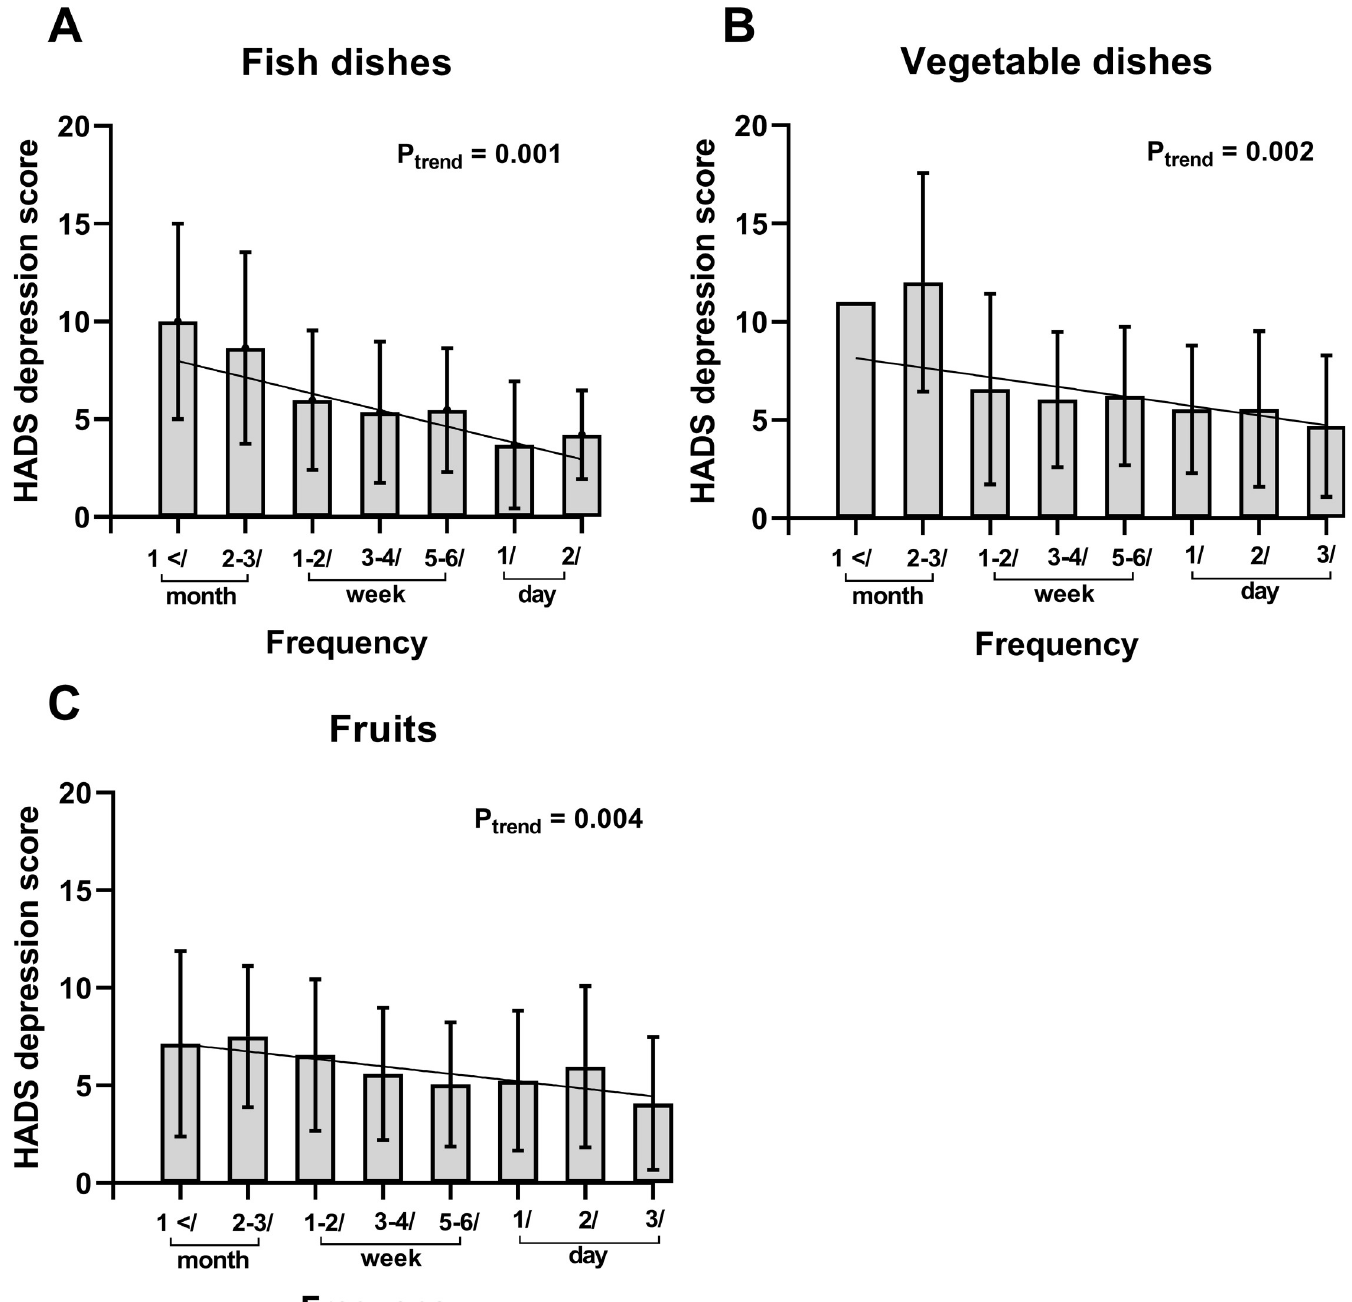
Fig 1. Trends of depression score by intake frequency. The vertical axis represents HADS depression score and the horizontal axis represents intake frequency of each category. 3 of 20 groups are negatively associated with HADS depression score; fish (A), vegetable (B), and fruits (C). P trend values are calculated by a Jonckheere- Terpstra trend test. Abbreviations: HADS hospital anxiety and depression